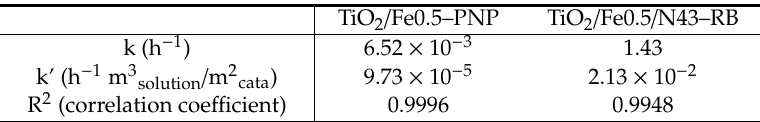
Table 4. Kinetic rate constants of reactions with TiO 2